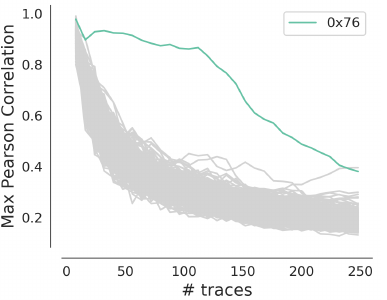
Figure 22: Maximum Correlation coefficients as a function of the number of traces in Step 3 (byte 0).